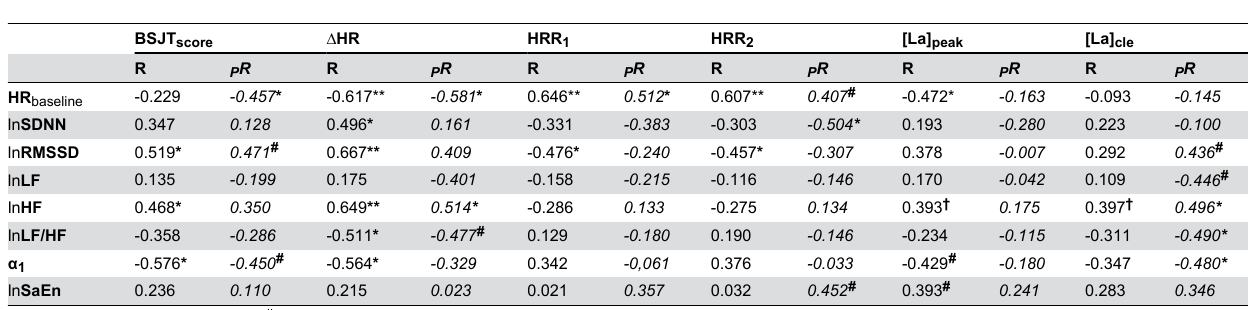
Abbreviations explained in Table 1. # p <0.1; * p <0.05; ** p <0.01. doi: